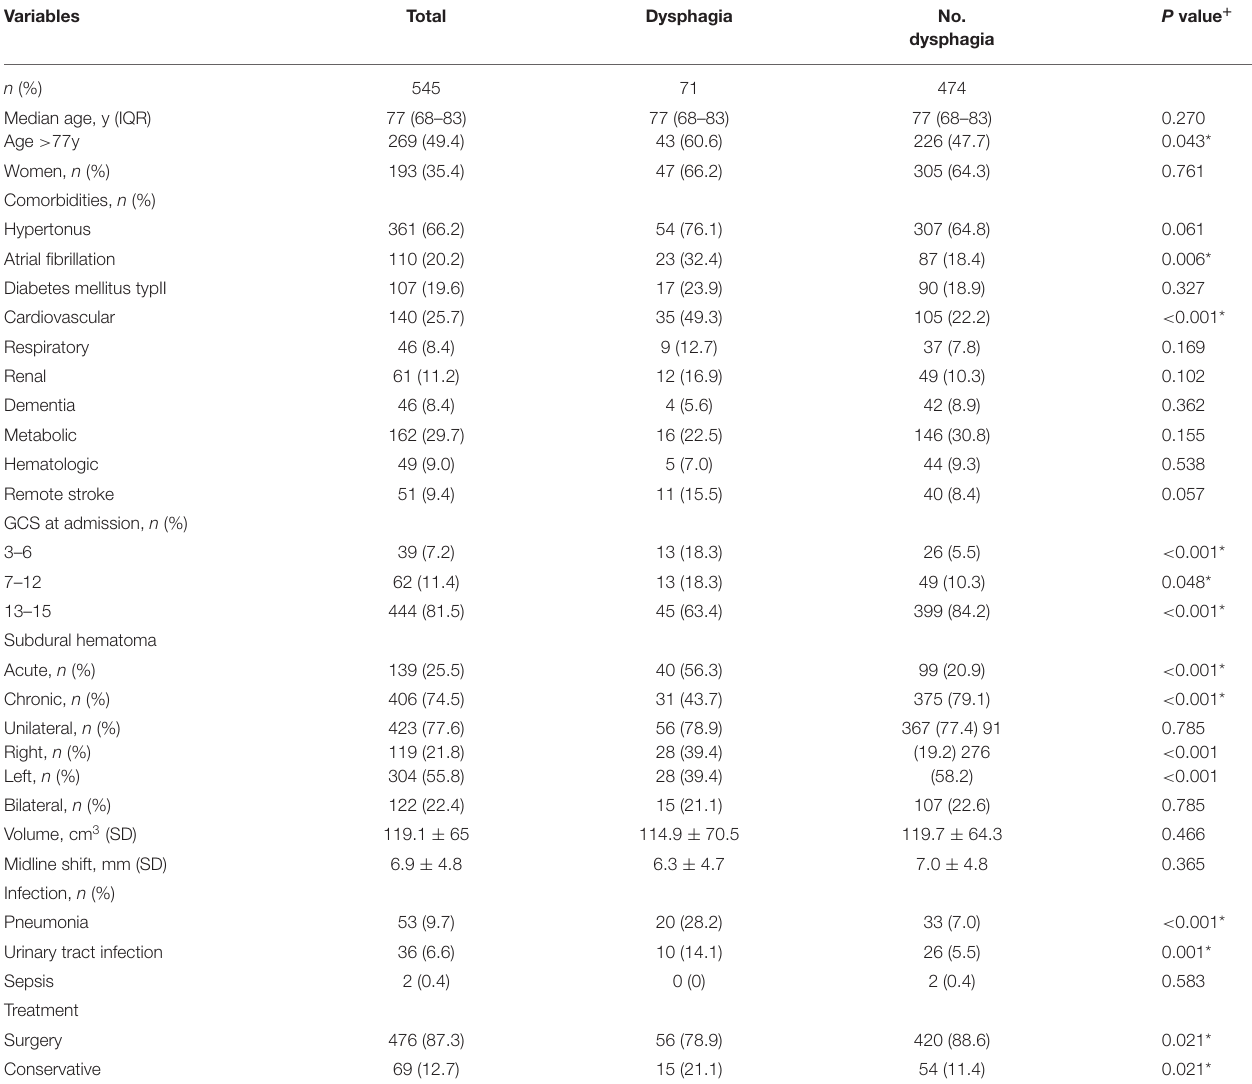
TABLE 1 | Baseline characteristics of the study population. Variables Total